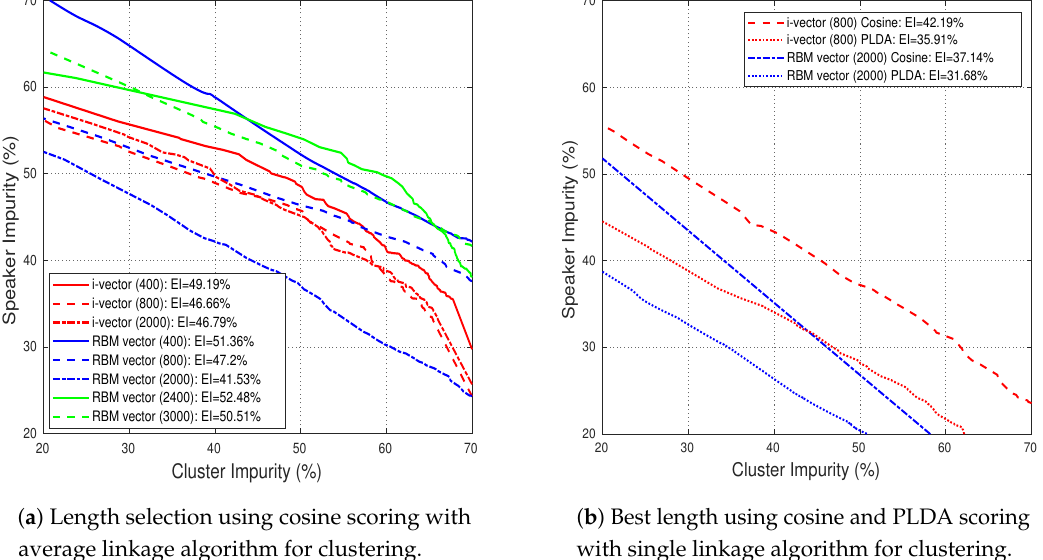
Figure 4. Comparison of Impurity Trade-off (IT) curves for the proposed RBM vectors with i-vectors. Different dimensions of RBM vectors are evaluated using different scoring and linkage algorithms for clustering. The dimensions of i-vectors and RBM vectors are given in